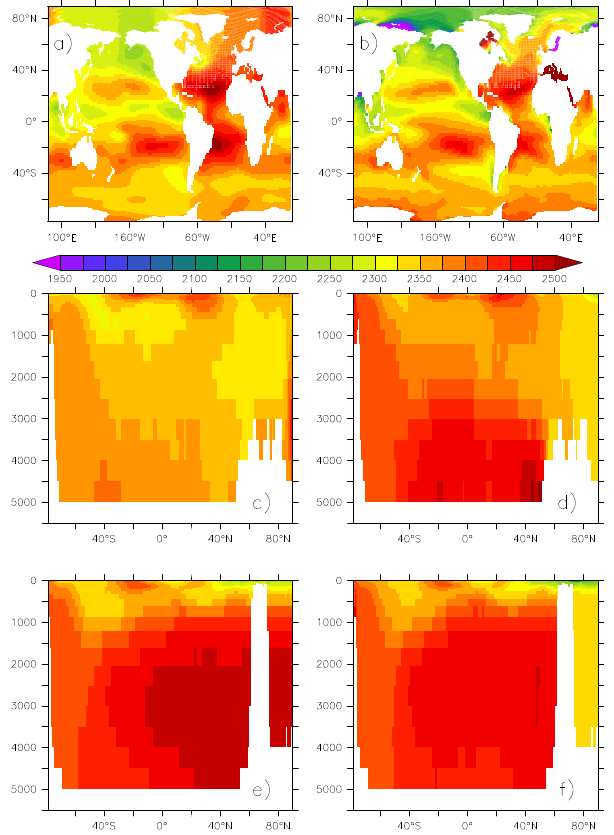
Figure 13. Annual-mean alkalinity concentrations in µmoleqL − 1 . Observations are from GLODAP. Panels are the same as on Fig. 9.